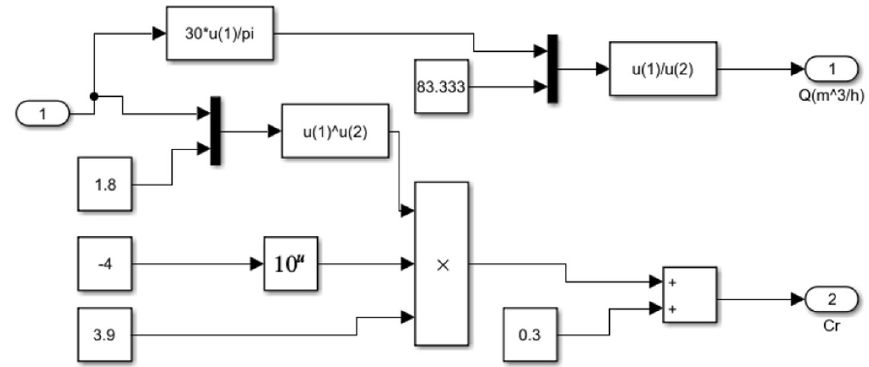
Fig. 7 Model of the centrifugal